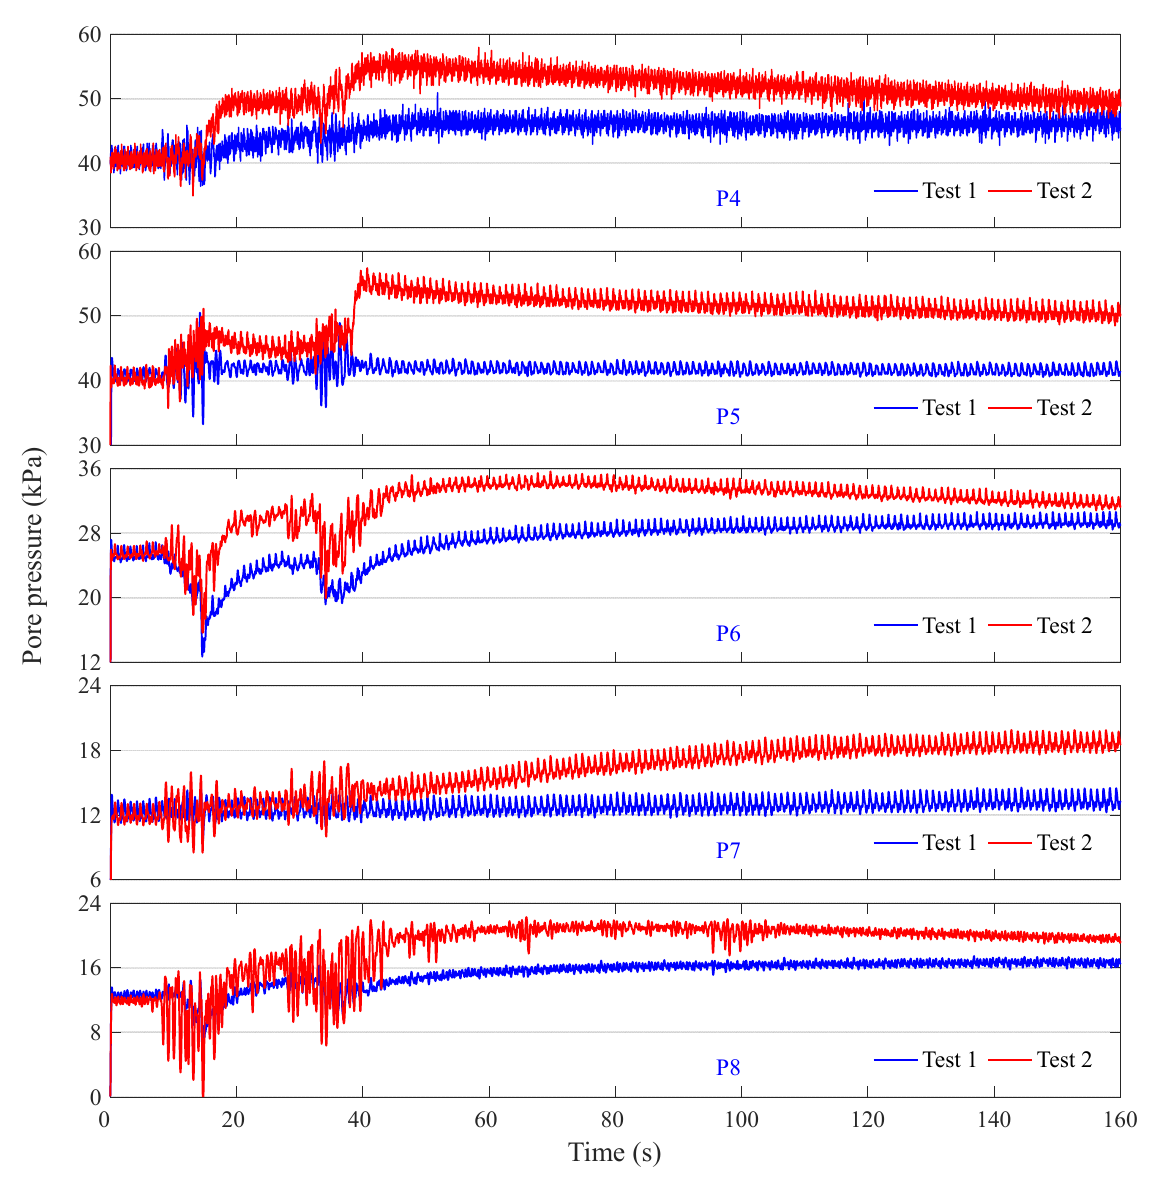
Figure 15. Time histories of pore pressure at typical positions in Test 1 and Test 2.